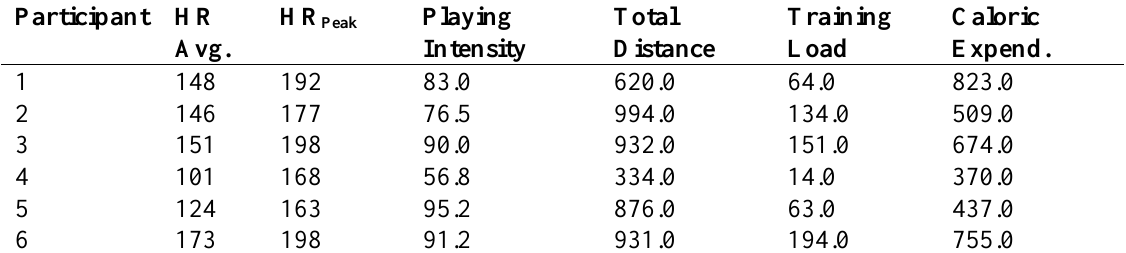
Table 3. Wheelchair basketball performance characteristics in Game